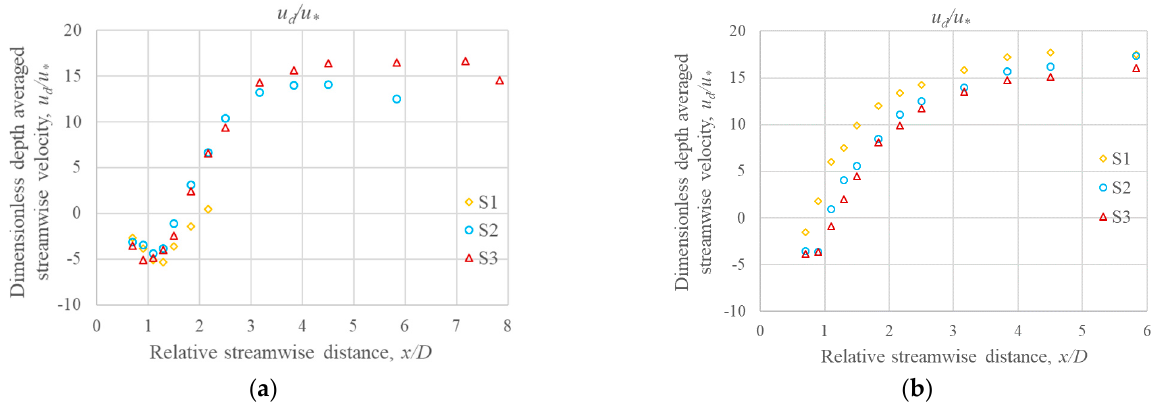
Figure 4. Variation of dimensionless depth-averaged streamwise velocity ( u d /u * ) in the symmetry plane: ( a ) midstream and ( b ) downstream.